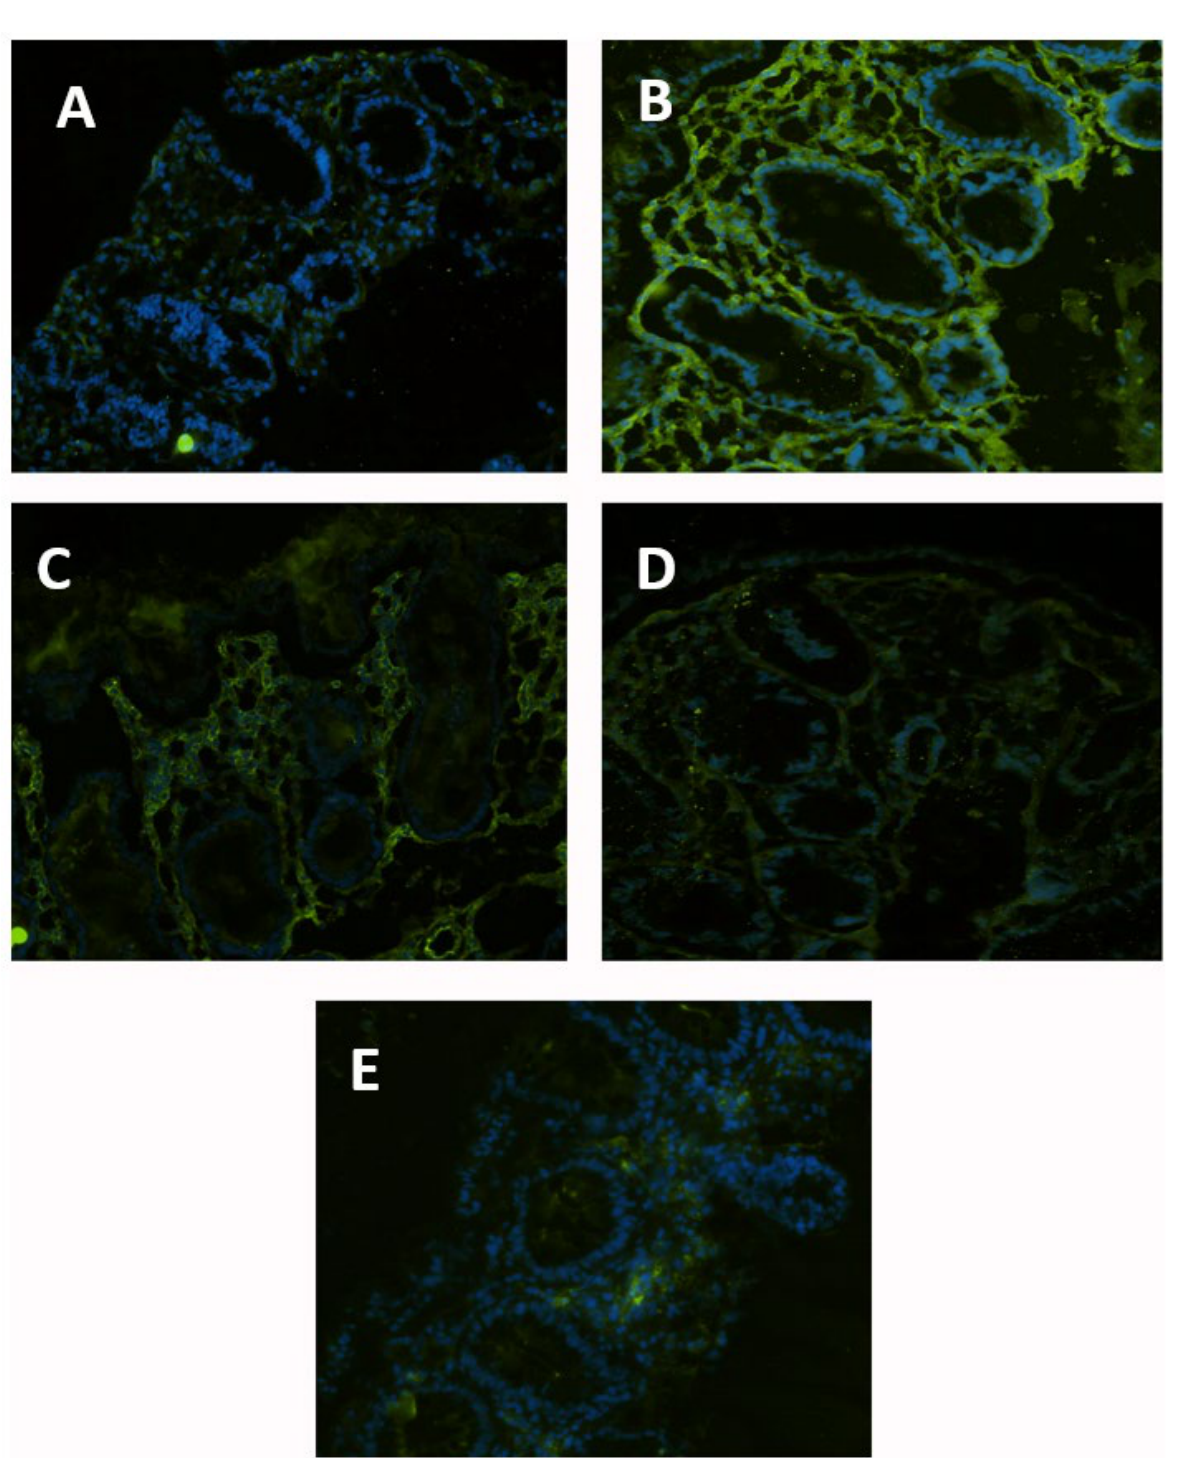
Figure 1. GAAE pre-treatment effect on ICAM-1 expression in normal controls challenged with EC-LPS. ( A ) Non-treated biopsy; ( B ) biopsy challenged with 1 µ g/mL EC-LPS for 18 h; ( C ) biopsy pretreated 3 h with 50 µ g/mL GAAE, then challenged with 1 µ g/mL EC-LPS for 18 h; ( D ) biopsy pretreated 3 h with 100 µ g/mL GAAE, then challenged with 1 µ g/mL EC-LPS for 18 h; ( E ) biopsy pretreated only with 100 µg/mL GAAE for 21 h .